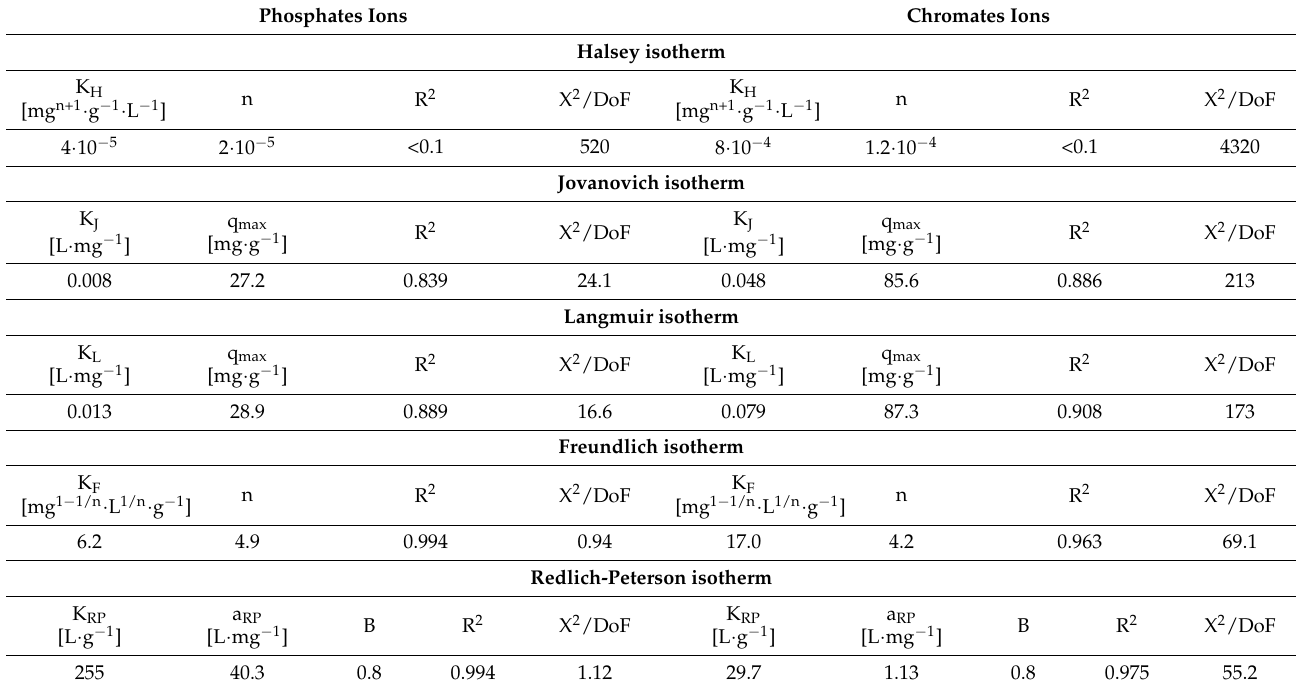
Table 7. Isotherm parameters for the adsorbed phosphates and chromates ions. Phosphates Ions Chromates